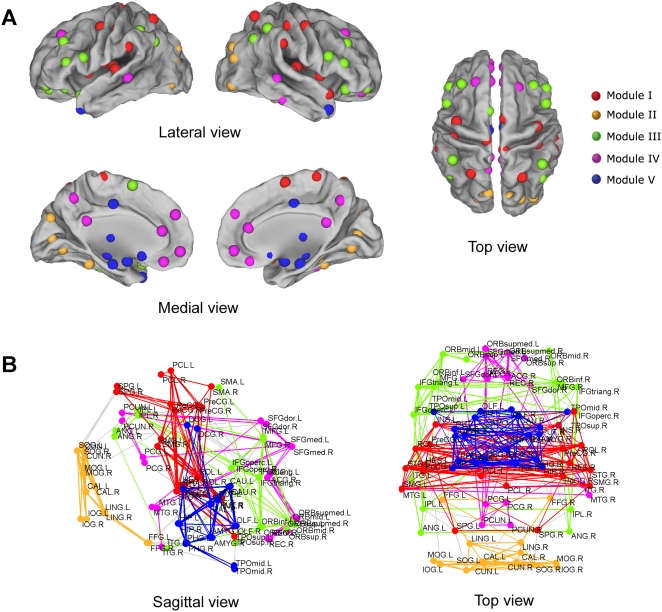
Surface and anatomical representation of modular architecture of the human brain functional network.(A) All of 90 brain regions are marked by using different colored spheres (different colors represent distinct network modules) and further mapped onto the cortical surfaces at the lateral, medial and top views, respectively, by using the Caret software [84]. Notably, the regions are located according to their centroid stereotaxic coordinates. For the visualization purpose, the subcortical regions are projected to the medial cortical surface according to their y and z centroid stereotaxic coordinates. (B) Sagittal and top views of the spontaneous brain functional network. The nodes and edges within each module are marked in one single color. The inter-module connections are shown in gray lines. For the abbreviations of the regions, see Table S1.